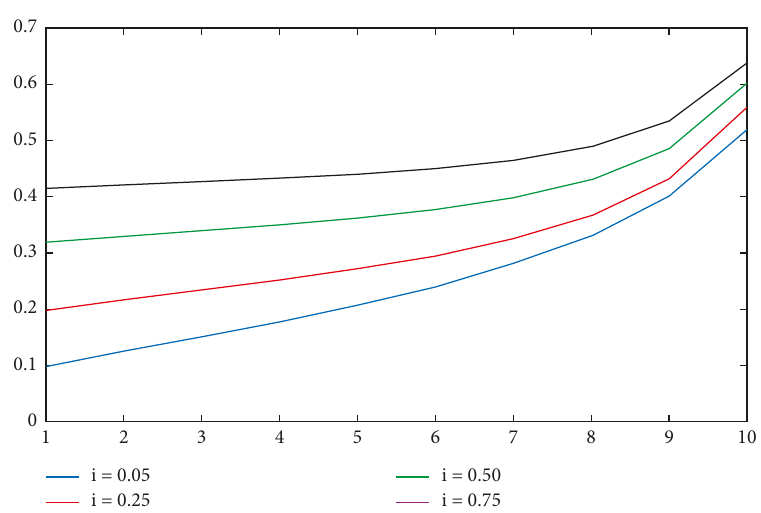
Figure 5: Relative consumption evolution by varying interest